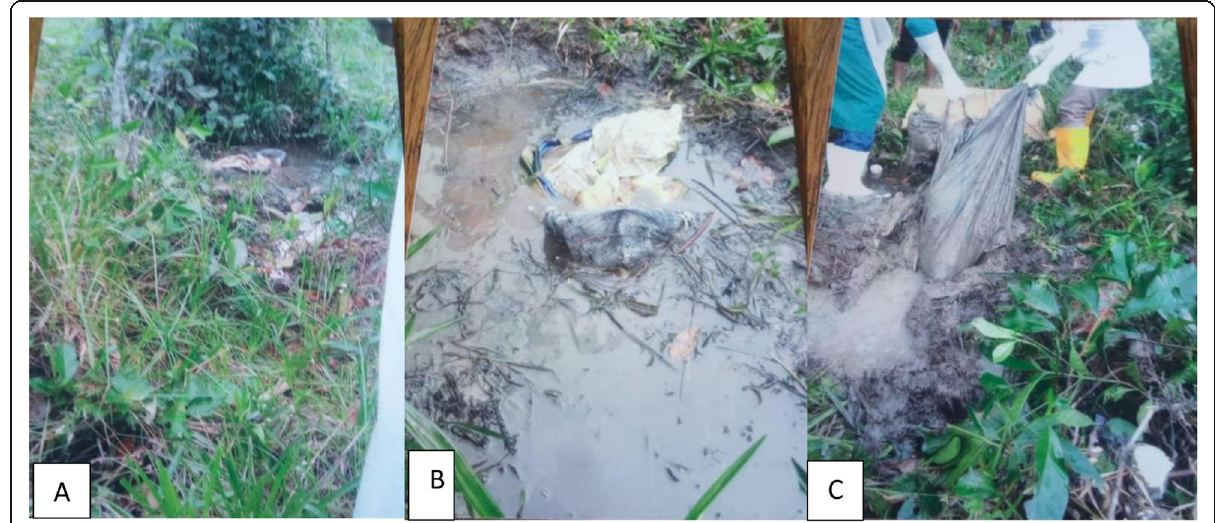
Fig. 6 a Grave in a swamp. b Closer shot after cutting surrounding grass. c Pulling out a sac bag containing the body. Digging to expose